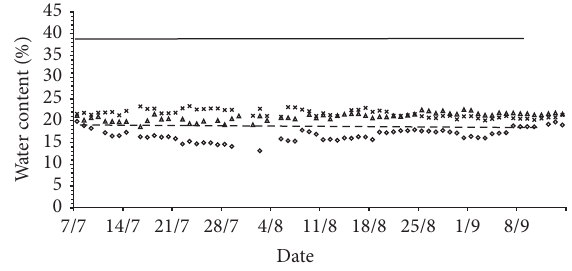
Figure 5: Temporal soil water content variation in the soil depth 𝑍 = 15 cm: at the inlet 𝑋 = 0 ( × ), at the behalf 𝑋 = 𝐿/2 ( 󳵻 ), and at the lateral end tip 𝑋 = 𝐿 (o)against ( 𝜃 dashed lines.